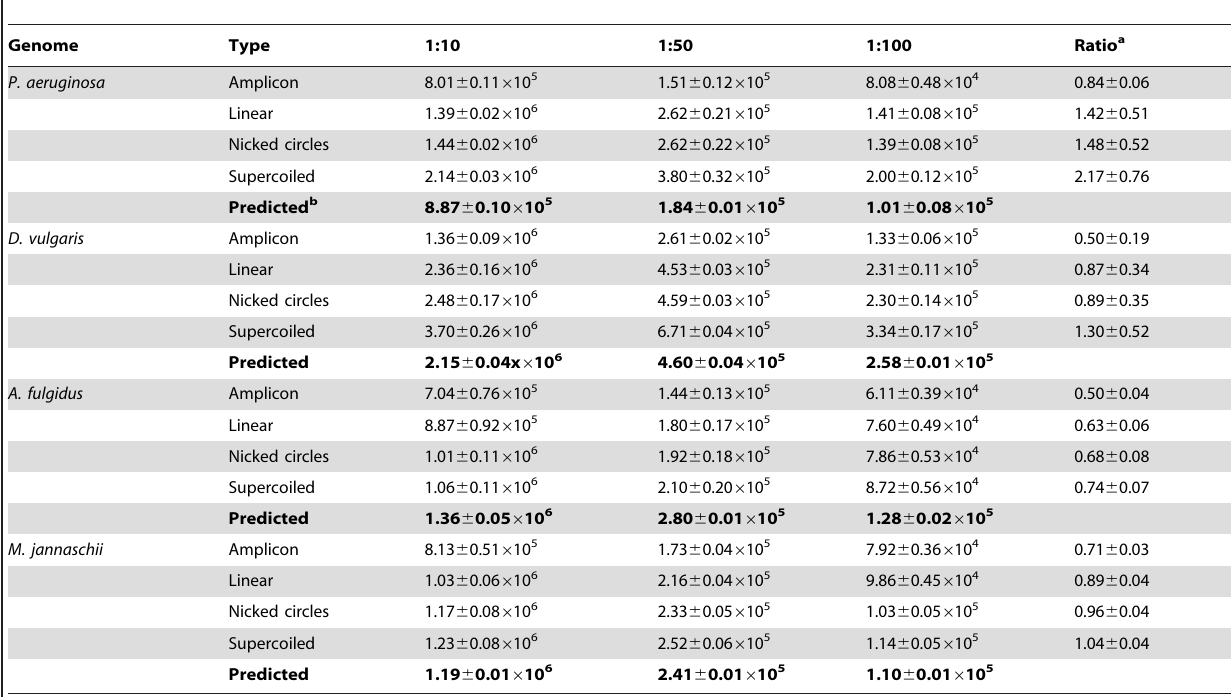
Table 4. Estimated and expected 16S rRNA gene copies in microbial gDNA samples based on qPCR standard